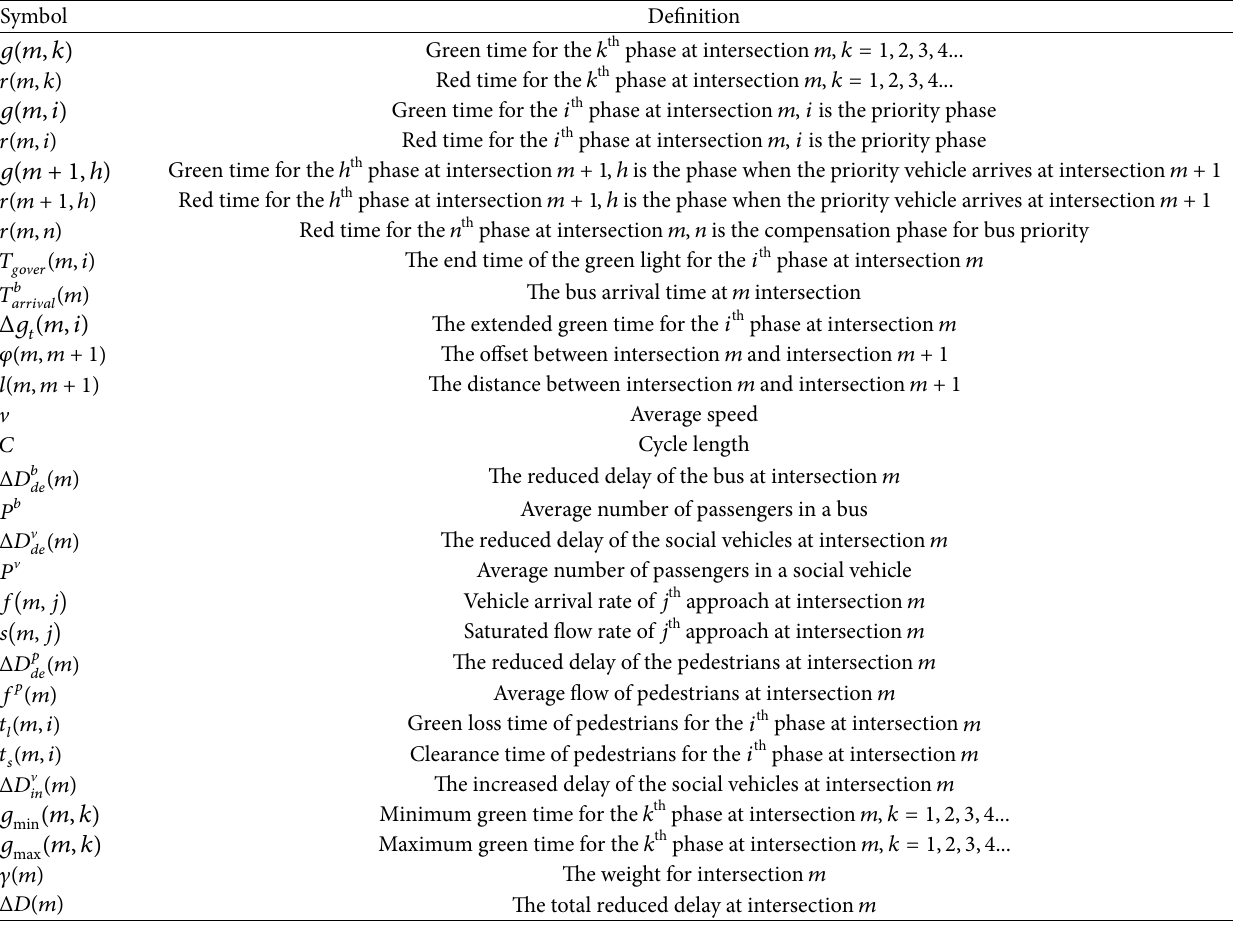
Table 1: Symbols and